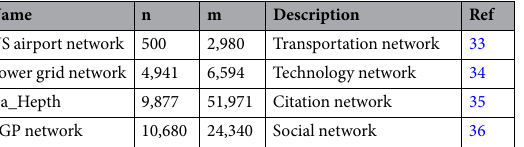
Table 2. Information of Real-world Networks with no known community structures. Here, n and m are, respectively, the numbers of nodes and edges in